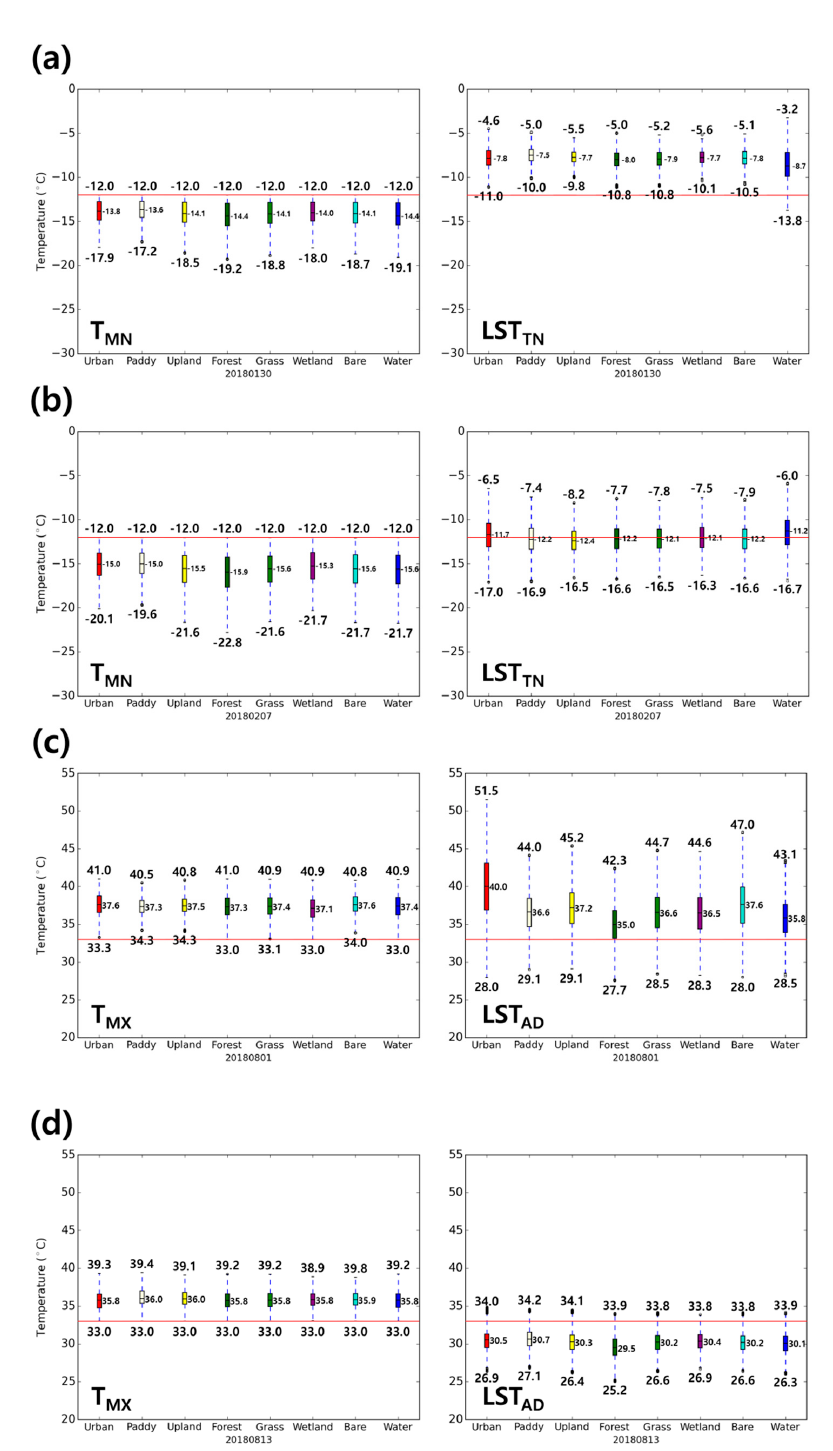
Figure A2. Boxplots of ( a , b ) observed T MN and LST TN for 8 land use classes (red: urban, light yellow: paddy, yellow: upland crop, dark green: forest, green: grass, purple: wetland, cyan: bare field, and dark blue: water) on January 30 and February 7, 2018, respectively, and ( c , d ) observed T MX and LST AD on August 1 and 13, 2018, respectively. In ( a , b ), the red solid line on the graph is − 12 ◦ C, which represents the reference temperature of the cold wave and in ( c , d ), the red solid line on the graph is 33 ◦ C, which represents the reference temperature of the heat